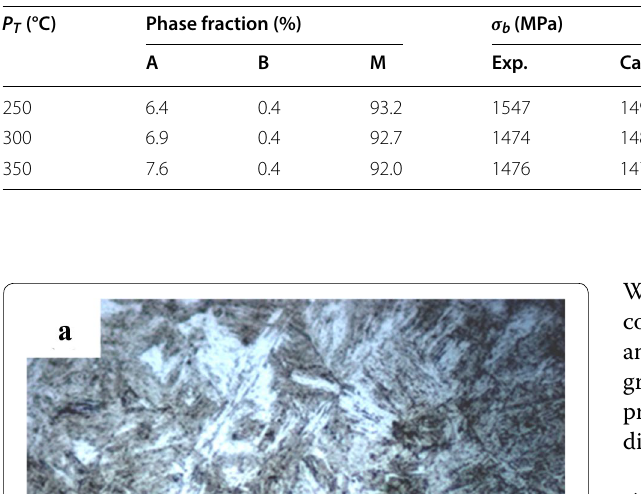
Table 5 Comparison between experimental and calculated phase fraction and mechanical properties for the flange of a U-cap part